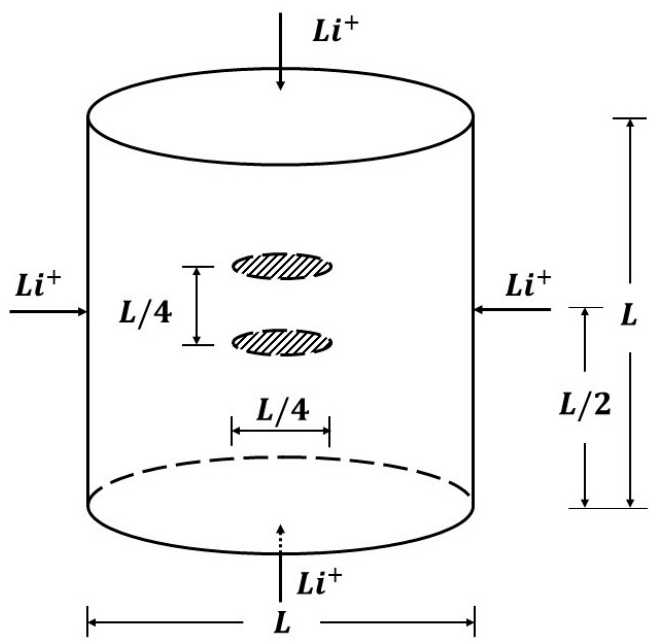
Figure 12. Cylindrical anode structure with pre-existing twin horizontal cracks.